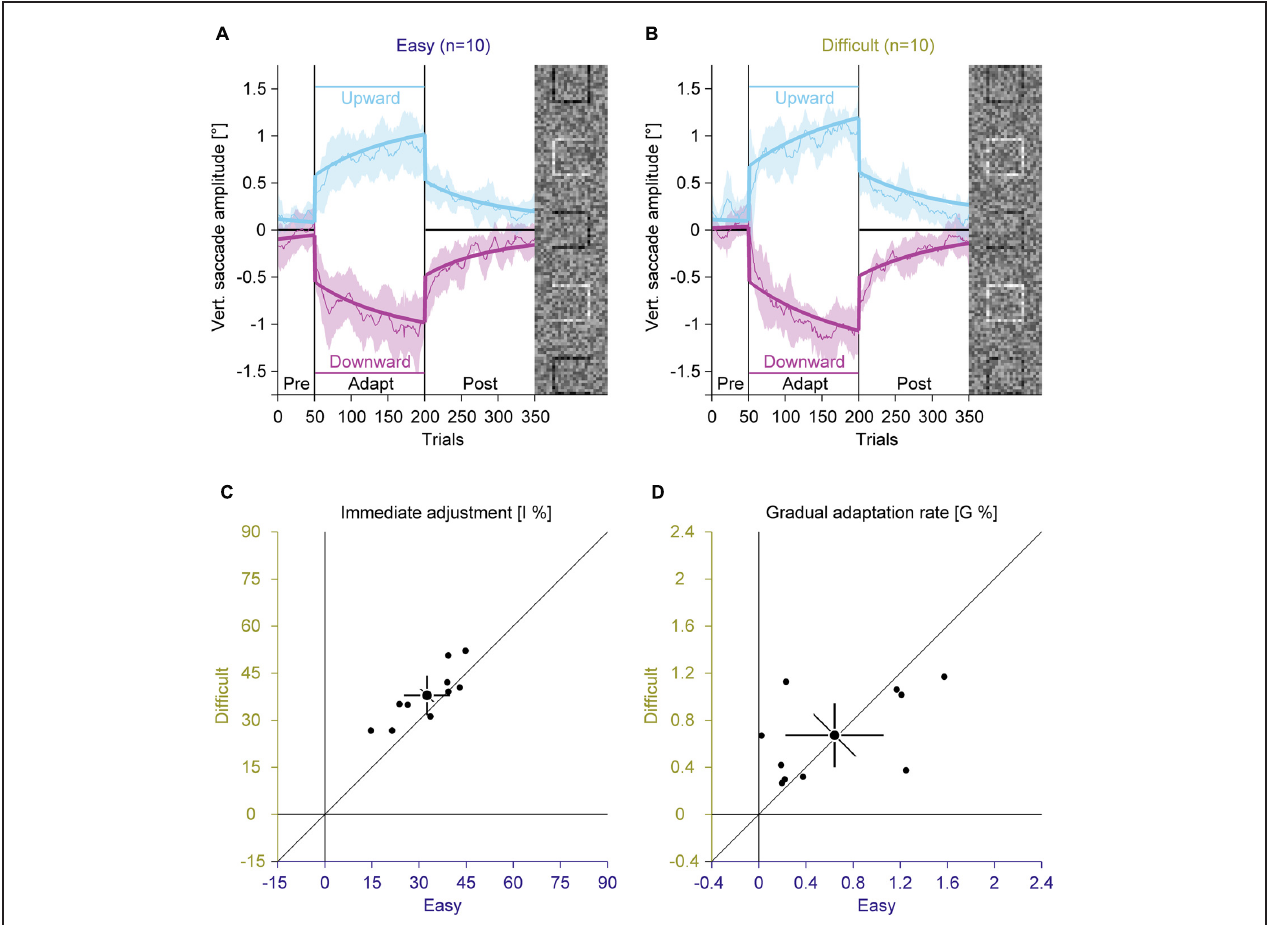
FIGURE 3 | Experiment 1, saccadic adaptation with easy and difficult perceptual task. (A) Saccadic adaptation with an easy perceptual task. (B) Saccadic adaptation with a difficult perceptual task. (A,B) The thin lines represent the average across observers. Data are smoothed by a running average with a bin size of 10 trials, for display. The shaded regions represent 95% confidence intervals. The thick lines represent the two-state model fit. Upward and downward adaptation is shown in blue and red, respectively. The vertical lines indicate the onset and offset of the adaptation phase. The horizontal lines indicate the location of the black discrimination square. In each trial, only one of the squares was displayed in black. (C) Immediate adjustment in the two-state model fits. (D) Gradual adaptation rate in the two-state model fits. (C,D) Small dots represent data for individual observers; large dots represent the mean across observers; Error bars represent 95% confidence